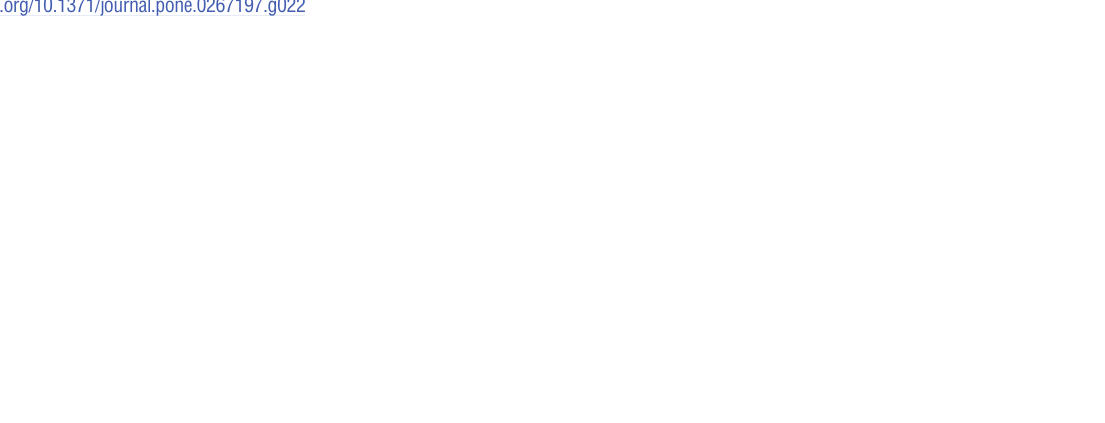
PLOS ONE | https://doi.org/10.1371/journal.pone.0267197 May 2, 2022 22 /